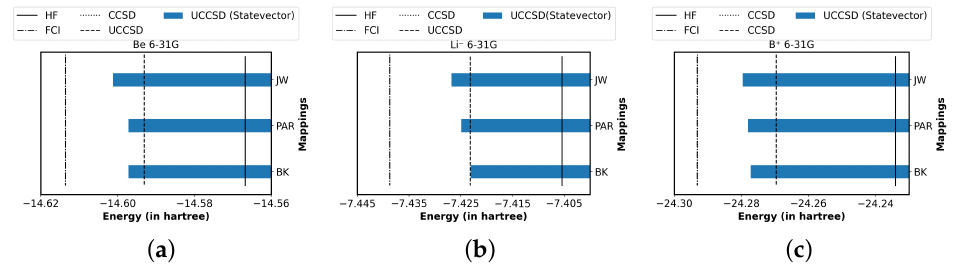
Figure 7. The results for the energies of the ( a ) Be, ( b ) Li − , and ( c ) B + in the 6-31G basis in the form of bar plots showing different combinations of fermion to qubit mapping techniques and backend simulators. The notations that have been adopted for this figure are the same as those for Figure